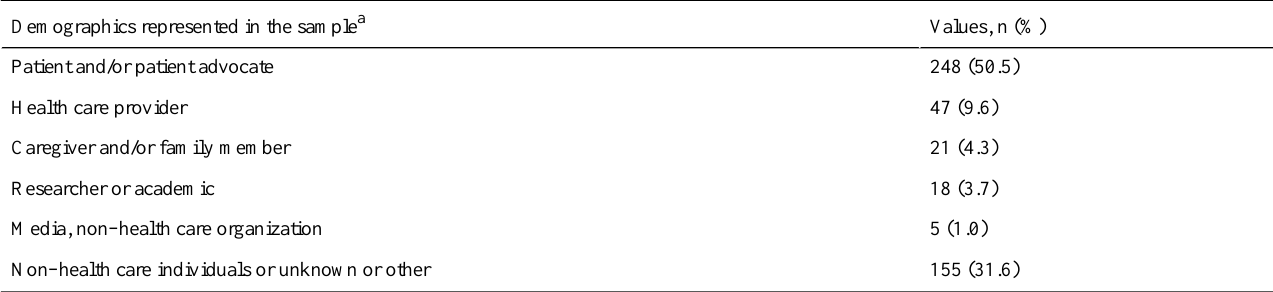
Table 1. Characteristics of Twitter users posting the hashtag #DoctorsAreDickheads